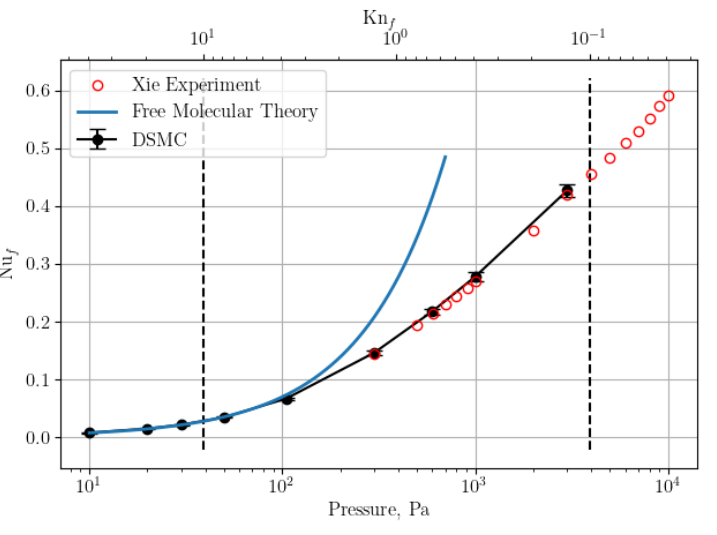
Figure 6. Comparison of free-molecular theory and experimental data to DSMC results at various pressure values (Knudsen number values). Error bars indicate ± 1 σ of the steady-state DSMC data. Dashed vertical lines indicate the approximate Knudsen number values that define the